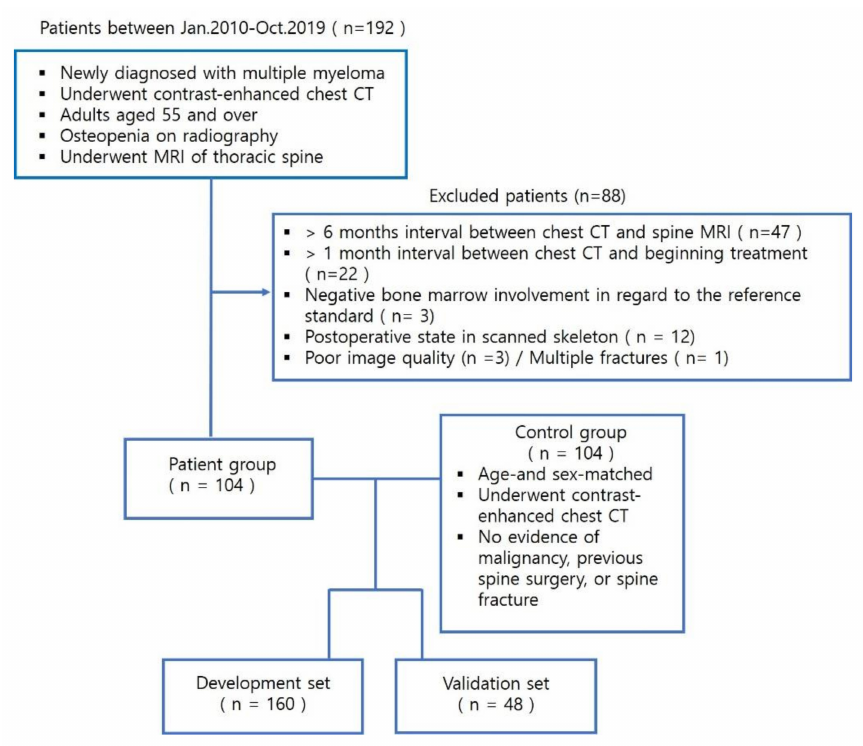
Figure 1. A flow chart of the participant selection